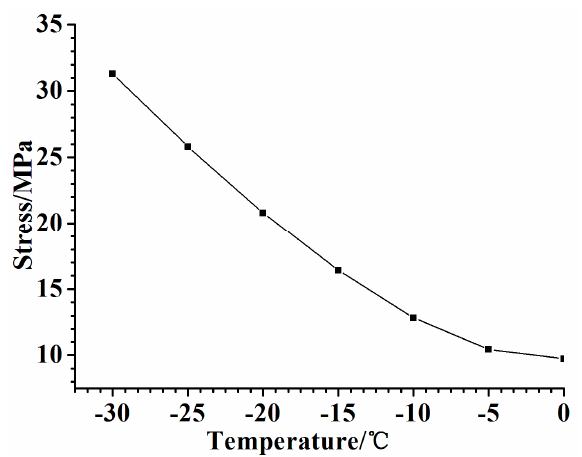
Figure 11. Failure stress - temperature curve.